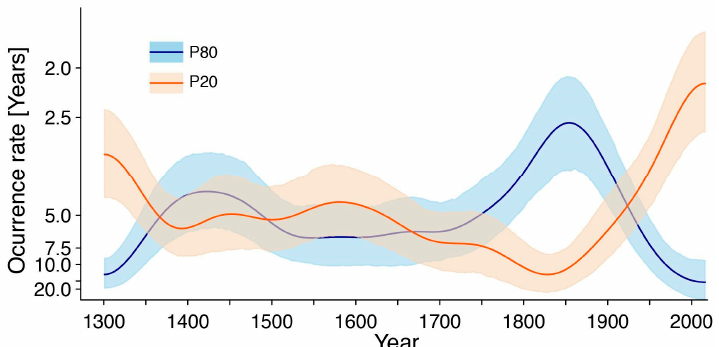
Figure 3. Changes in the occurrence rate of water extreme events based on the streamflow reconstruction, and calculated for the period 1300–2015. The 20th percentile (0.38 m 3 s − 1 ) was used to identify dry years, while for wet years the 80th percentile value threshold (1.07 m 3 s − 1 ) was used. The confidence band at 95% confidence level is shown around the Kernel-based curves, and was obtained using 1000 bootstrap simulations.